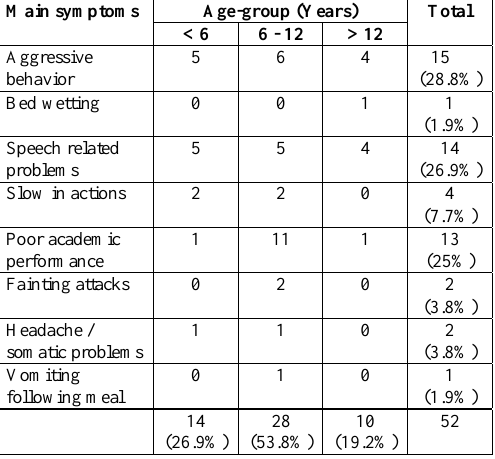
Mental and behavioural symptoms vs. age-group.